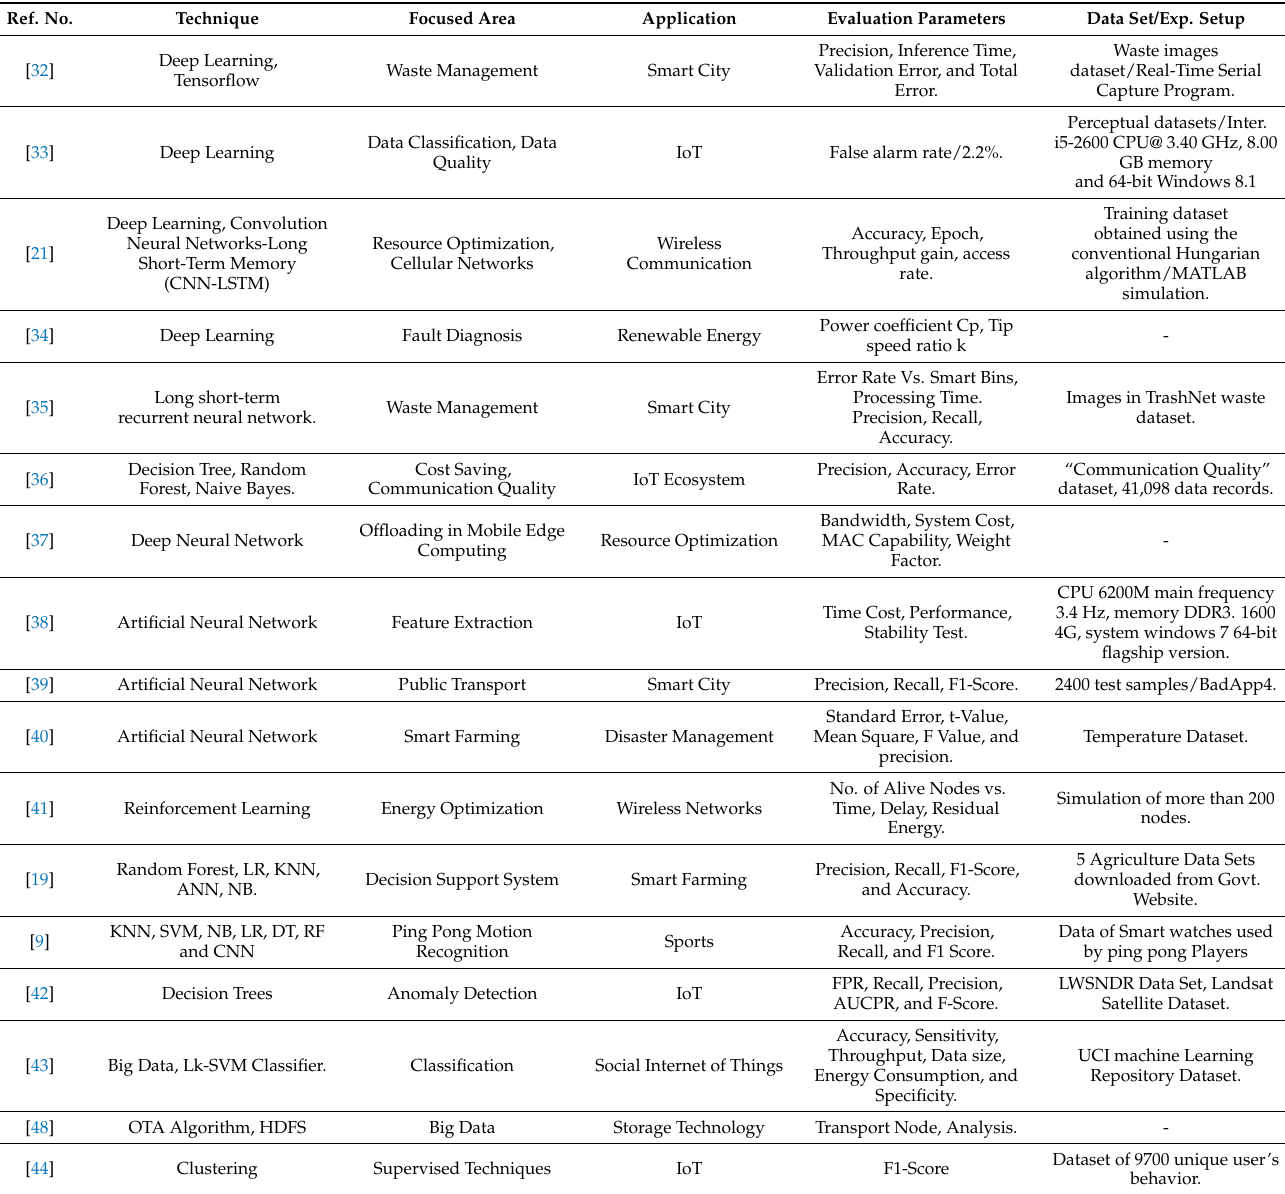
Table 1. Recent Advances in Machine Learning Techniques/Internet of